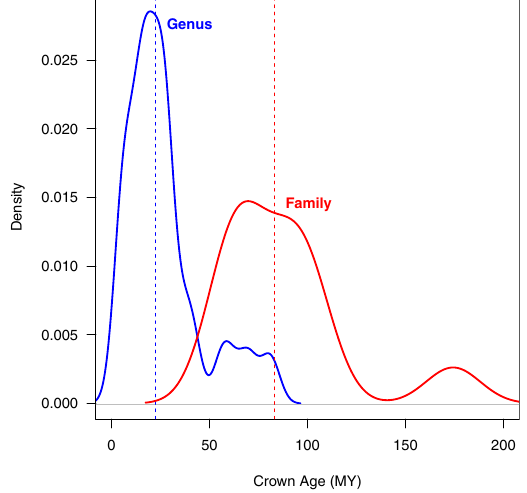
Figure 1. Distribution of crown ages of currently accepted genera (blue) and families (red) in the studied data set (Parmeliaceae, Ascomycota). The median for both ranks indicated by a dashed